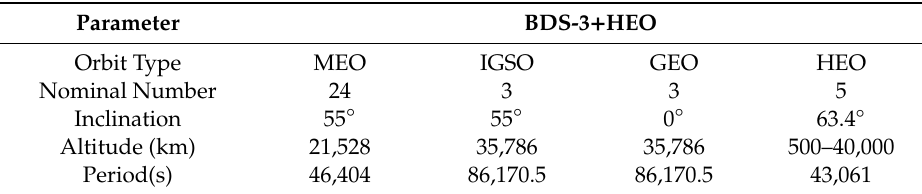
Table 6. Parameters of the BDS-3+HEO constellation.